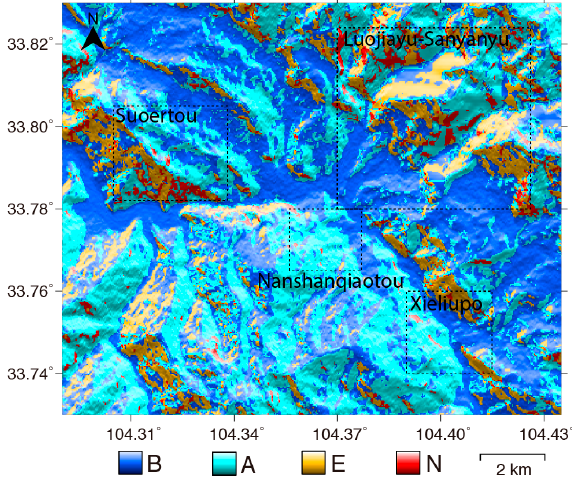
Figure 6. Integrating result of the geometric distortions of the ALOS ascending and ENVISAT descending data. B: appropriate for both data; A: appropriate for ALOS data; E: appropriate for ENVISAT data; N: appropriate for neither data.